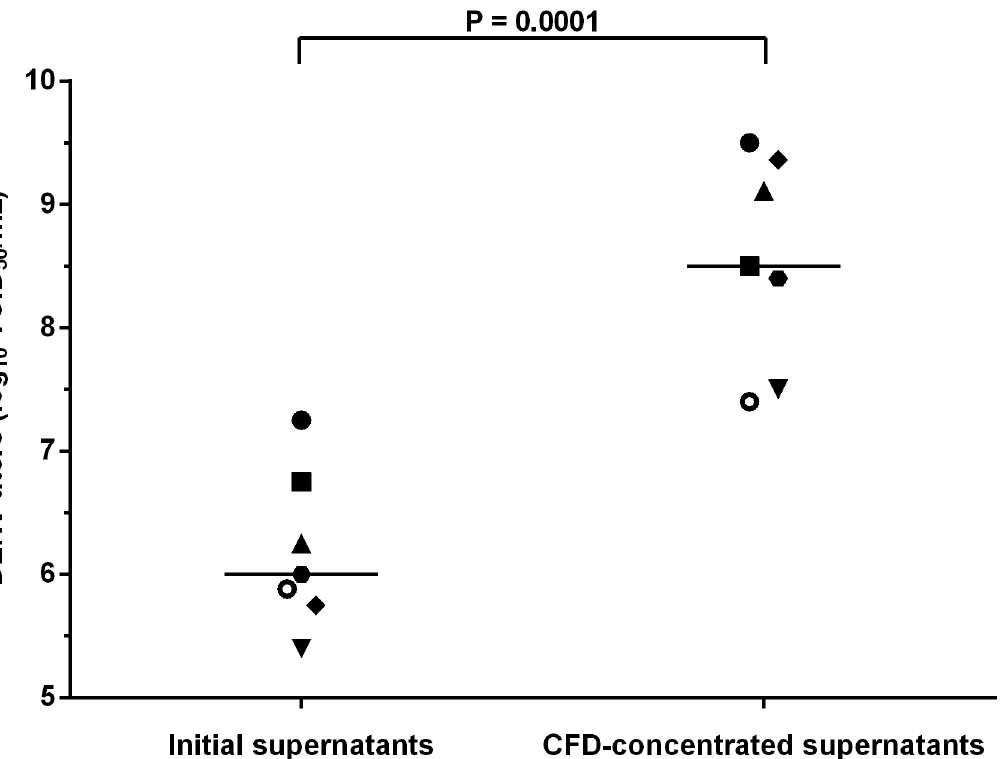
Fig 1. Effect of using centrifugal filter device on DENV titers in C6/36 cell-culture supernatants. DENV titers in C6/36 cell-culture supernatants were evaluated before and after concentration with Centricon Plus-70 centrifugal filter devices (CFD; Millipore, Germany). Viral titers were significantly higher after CFD concentration (Paired t-test, P = 0.0001) with an evolution of the median titer (line) from 6.00 to 8.50 log 10 TCID 50 /mL. DENV = Dengue virus.